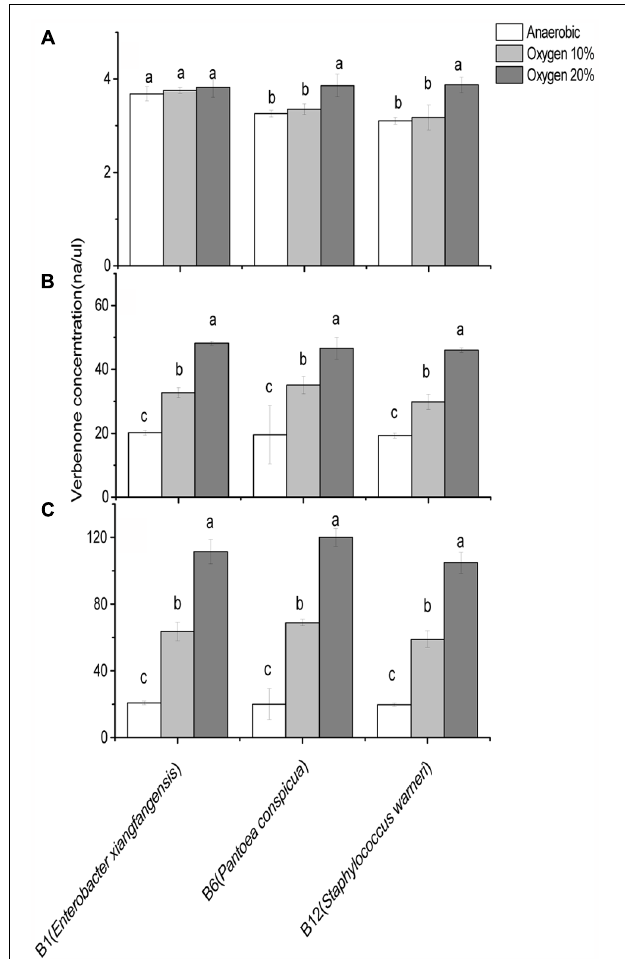
FIGURE 5 | Comparison of cis -verbenol to verbenone conversion ability of Dendroctonus valens gut associated facultative bacteria under different oxygen concentrations. Three bacteria from Dendroctonus valens gut are compared in terms of their cis -verbenol to verbenone conversion ability at (A) 4 ng/ µ l, (B) 40 ng/ µ l, and (C) 200 ng/ µ l cis -verbenol concentrations. Statistical analysis was performed using Dunnett’s T 3 test. The bars with different letters are significantly different at P =